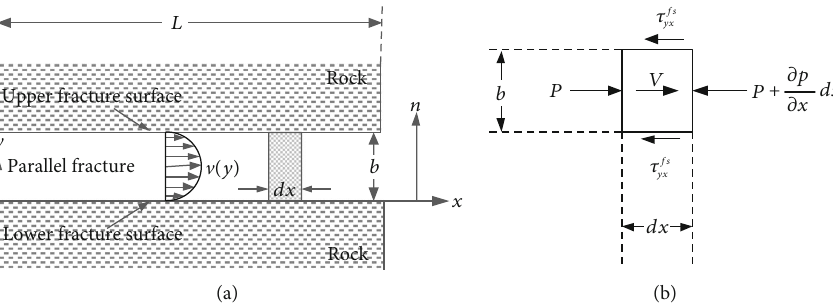
Figure 1: The two-dimensional ideal mechanical model of seepage in rock fractures: (a) model structure and mechanical characteristics and (b) mechanics characteristics of seepage liquid in dx